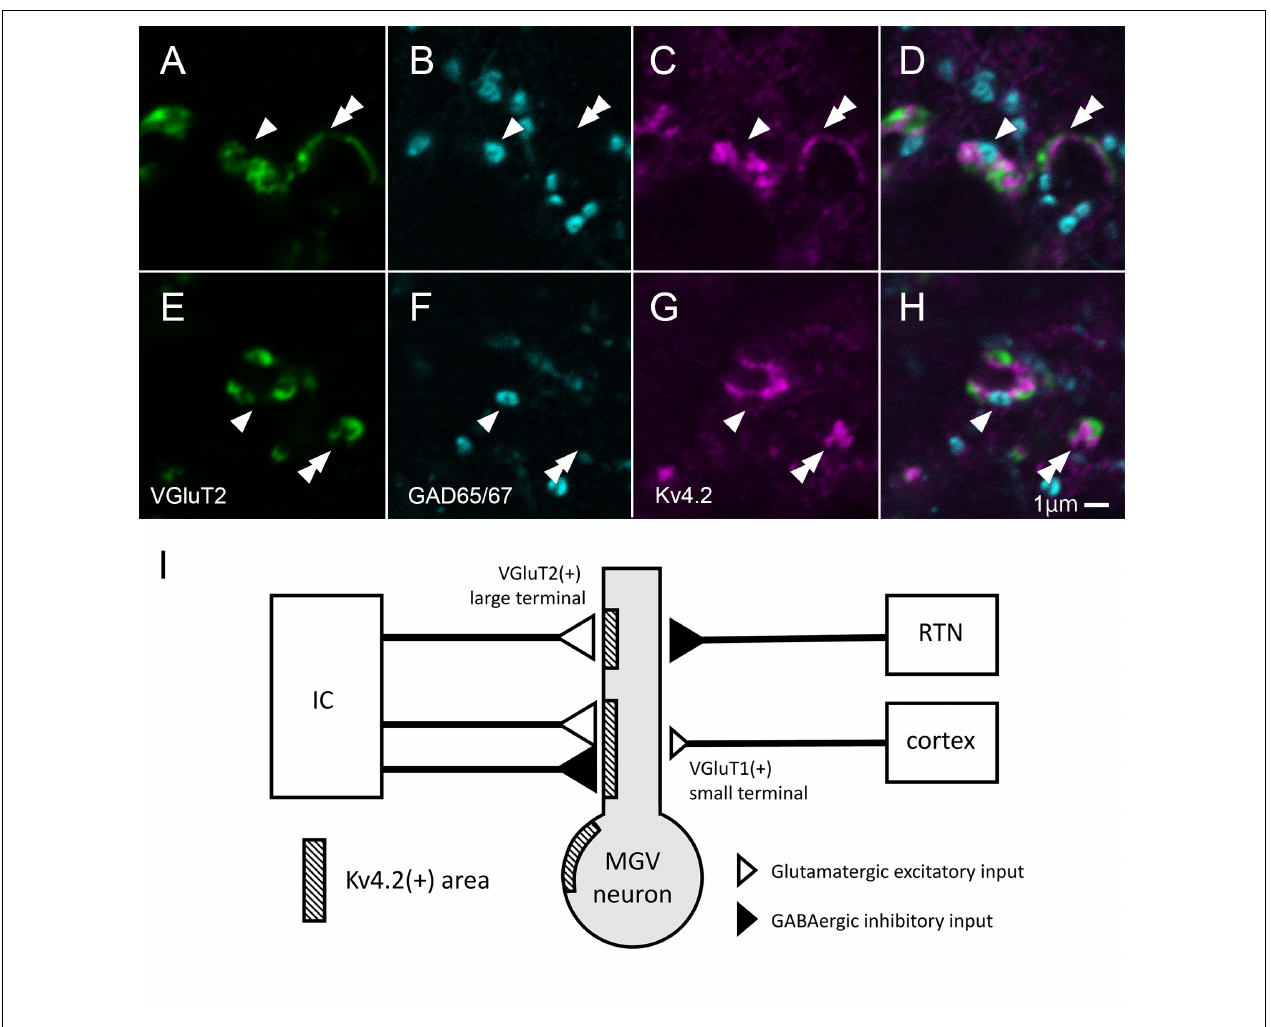
FIGURE 10 | Some of Kv4.2-positive domains receive contact with both VGluT2 excitatory and GABAergic inhibitory axon terminals. (A–H) Triple fluorescence labeling for VGluT2 (green; A,E ), GAD65/67 (cyan; B,F ), and Kv4.2 (magenta; C,G ) in the mice MGV. Arrowhead: Kv4.2-positive structure that is closely opposite to both GAD65/67-positive terminal and VGluT2-positive terminal. Double arrowhead: Kv4.2-positive structures that are closely opposite to VGluT2-positive terminals but not to GAD65/67-positive terminals. (I) A summary schematic diagram representing the relationship between Kv4.2-positive structures and glutamatergic and GABAergic inputs from the IC, RTN, and cortex. Scale bar: 1 µ m (A–H) . GABA, gamma-aminobutyric acid; GAD, glutamic acid decarboxylase; IC, inferior colliculus; Kv4, Shal-related subfamily of potassium voltage-gated channel; MGV, ventral medial geniculate; RTN, reticular thalamic nucleus; VGluT2, vesicular glutamate transporter